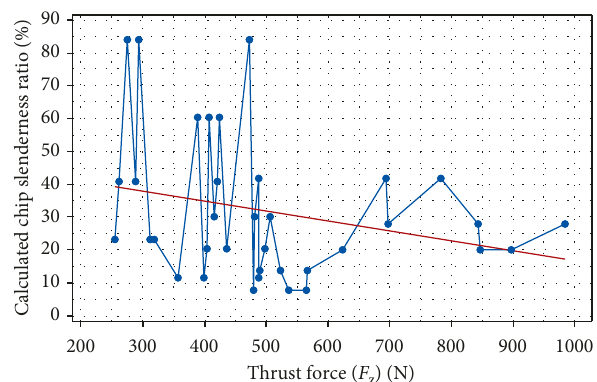
Figure 5: Effects of the experimental and theoretical chip slen- derness ratios on the thrust force.